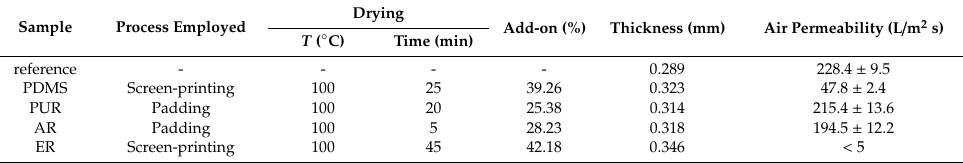
Table 2. Add-on, thickness and air permeability of coated PES.